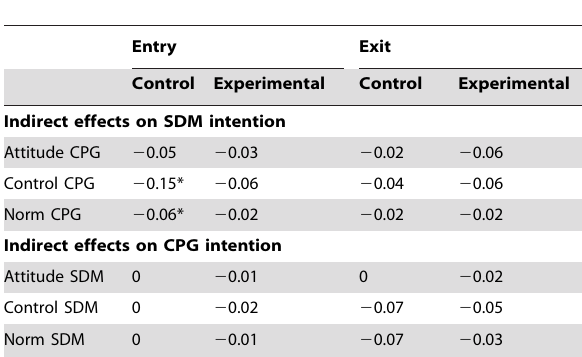
Table 4. Indirect effects on each